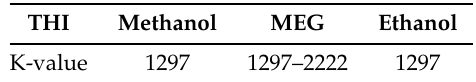
Table 2. K-value for Hammerschmidt equation found in literature [12,13].